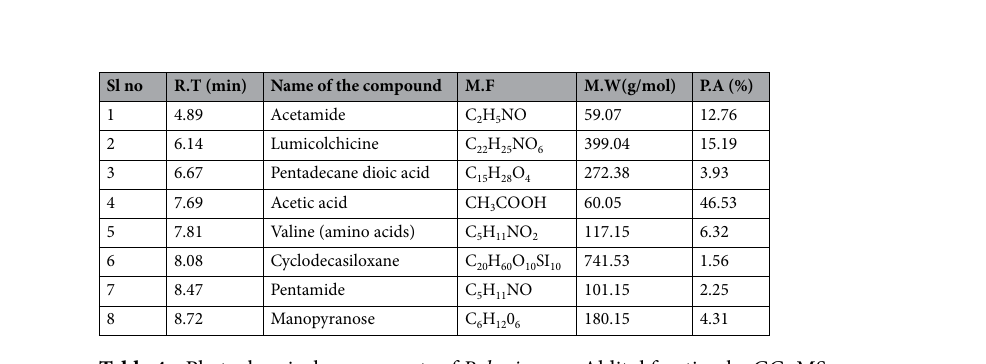
Table 2. GC–MS unsaturated fatty acid detection. The ethyl acetate extracted fractions of organic fermented samples revealed the major bioactive compounds, interpreted through the GC–MS NIST 14. L. The representation of bioactive compounds is tabulated with peak concentration (%), retention time (R.T.), molecular formula, molecular weight and weight percentage with 100 mg/ml. Tables 3, 4, 5, 6, and 7 and supplementary method 4 fermented extracts namely kadukkai ( T. Chebula) resulted in the form of unsaturated fatty acids compounds like citric acid, hexadecenoic acid, trans-octadecanoic acid, 13-octadecanoic acid and 6-octadecenoic acid with the overall unsaturated fatty acid percentage quantified around 54.1%. Neelamari ( Indigofera tinctoria) chro- matogram fractioned adipic acid, demecolcine, nalmefene, strychnine, cholestane-6-one, aspidodasycarpine, cyano, rhodopin, lycopene, phosphine with 80.78% in 100 mg/ml concentration 34 (Nayar 1999). Palm jaggery (refined sugar) depicted the acetamide, lumicolchicine, pentadecanedioic acid, acetic acid, valine (amino acid), cyclodecasiloxane, pentamide and manopyranose content around 92.85%. The high-level acetic acid observed in palm jaggery reacts with the lime particle forming calcium acetate to promote the hydration properties due to the carboxyl groups to enhance the initial strength and internal voids the mortar 46,52–54 . Sucrose is the most common sugar, made up of α-glucose and β-glucose linked together by a glycosidic bond. The hydroxyl groups make the molecule highly water-soluble. As far as the lime traditions are concerned, the use of sugars has been documented in historic lime mortars in various countries where its interaction with C–S–H has been observed by adsorbing the Ca (OH) 2 to increase the binding properties of the mortar. The addition of jaggery to Lime increases the solubility of Lime in water by 84%. Hence, instead of water jaggery extract, water can be added during slaking. It helps in more conversion of calcium oxide (Lime) into calcium hydroxide (portlandite). Jag- gery contains 60–85% sucrose, 5–15% glucose and fructose, 0.4% protein and 0.6–1% of minerals 9 . Hibiscus ( Rosa Sinensis) contained hexadecenoic acid, 14-octadecadienoate, tetracontane, fumaric acid (pigment), tri- triacontane, 9-octadecene and hentriacontane ranging around 8.37%, resulting in a very low unsaturated fatty acid from the chromatogram. Table 11 Aloe vera ( Xanthorrhoeaceae) recorded the pentanoic acid, tetradeca- noic acid, n-hexadecenoic acid, oleic acid,9-octadecanoic acid and docosanoic acid around 47.72% from the chromatogram 22,53 . The reduced unsaturated fatty acid was observed due to the polysaccharide presence (starch, cellulose and glycogen) in hibiscus organic fermented extract shown in Table 12 17,31 . The higher unsaturated fatty acid was found in palm jaggery, followed by T. chebula and aloe vera fermented extracts, in agreement with CO 2 quantified liberation observed. The role of unsaturated fatty acid compounds in the fermented extracts interacts with the lime particles to improve the water-resistance, mechanical strength and enhance the microstructure’s formation. Hence the addition of unsaturated fatty acids have at least one double bond between carbon atoms, and they are thus more reactive and produces compact mortar (Zhang, & Zheng, 2014; Rampazzi et al., 2016).